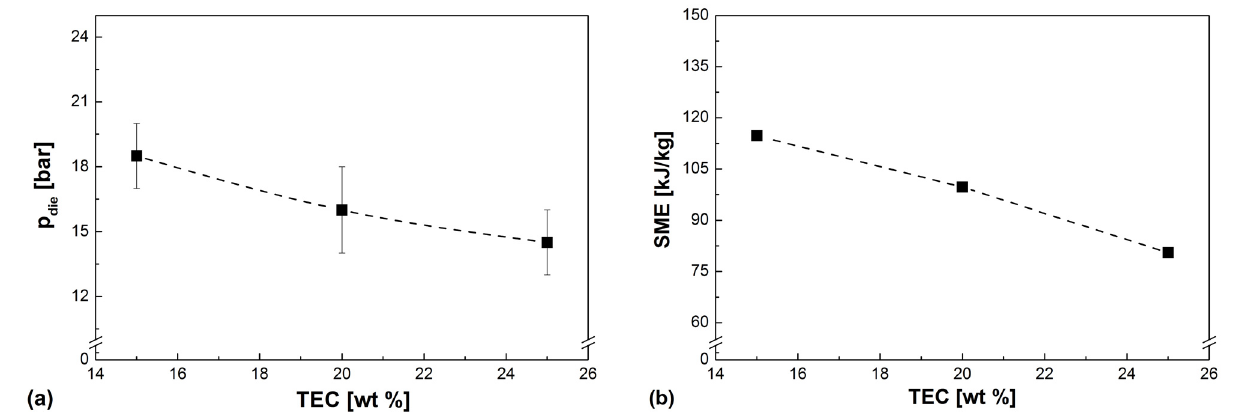
Figure 5. ( a ) Die pressure p as a function of TEC content; ( b ) Specific mechanical die energy input SME as a function of TEC content.